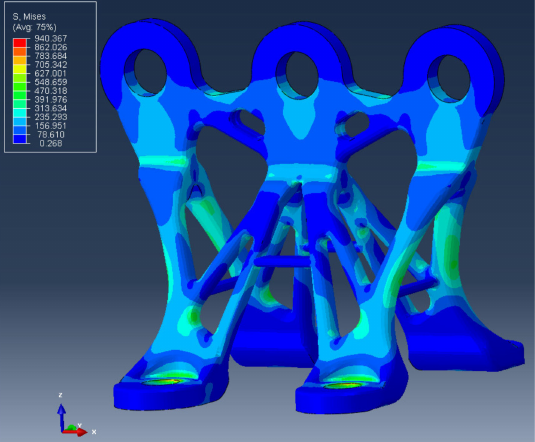
Figure 12. The numerical simulation result of the reconstructed geometry subjected to 50 kN vertical